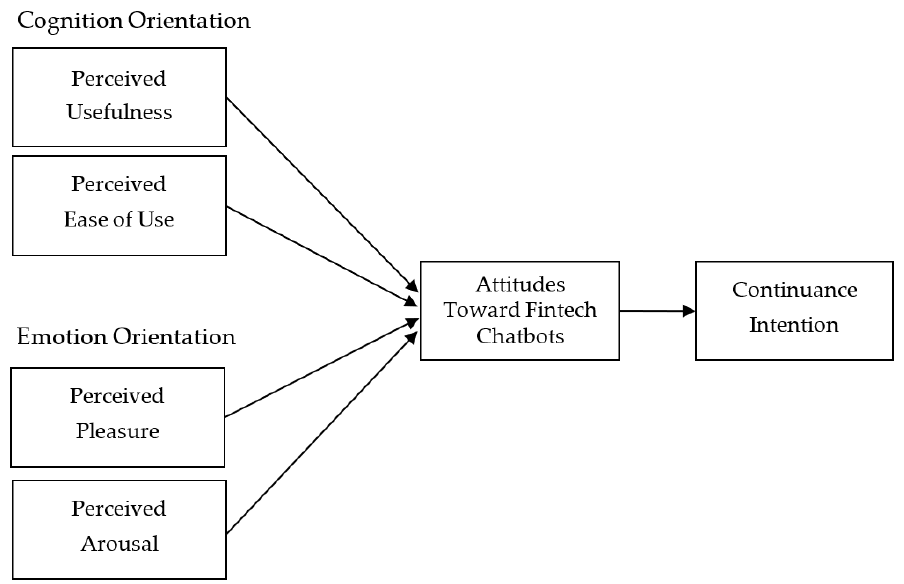
Figure 1. Proposed model.